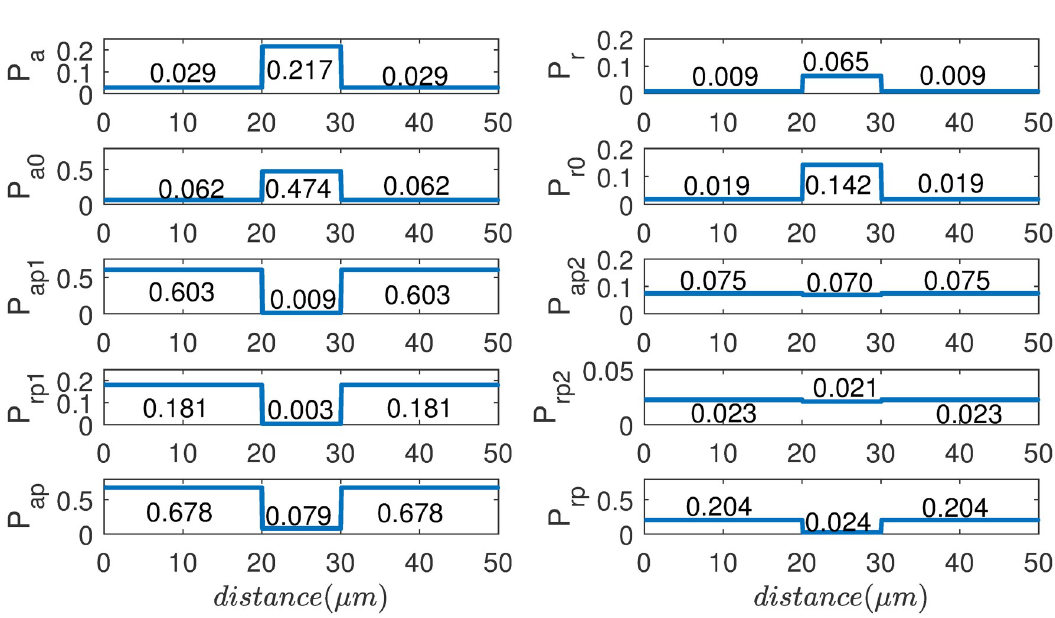
Fig 4. The distribution of NFs in each state at dynamical equilibrium by velocity reconstruction in the ‘8-state’ model.